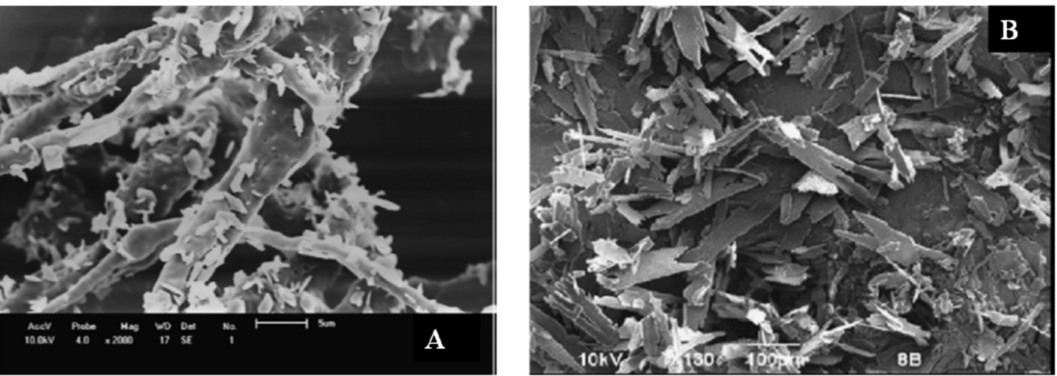
Figure 6. Scanning electron micrographs of β -carotene encapsulated in poly